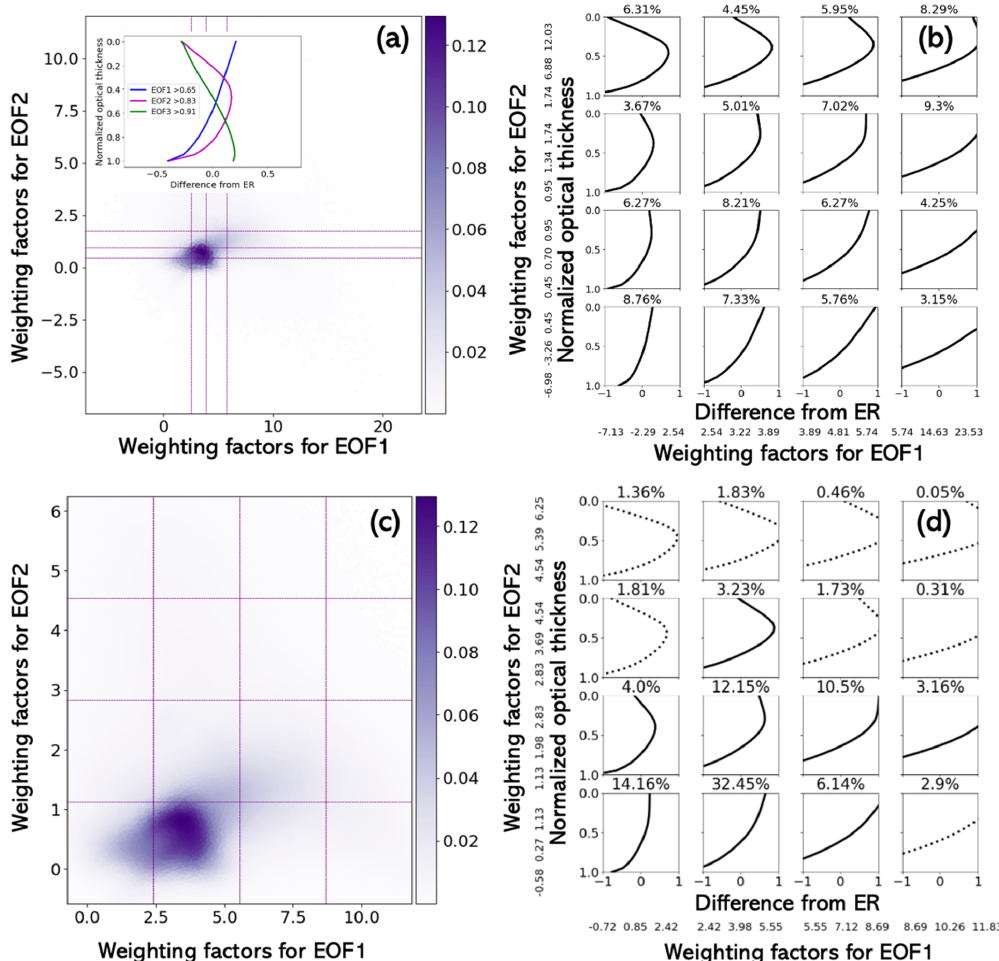
Figure 5. Same as Fig. 4 but for all ER profiles.